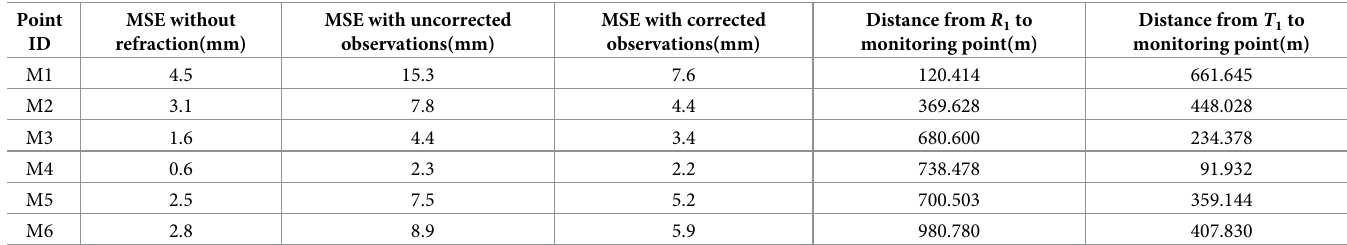
Table 2. Vertical displacement accuracy comparison with observation correction. Point